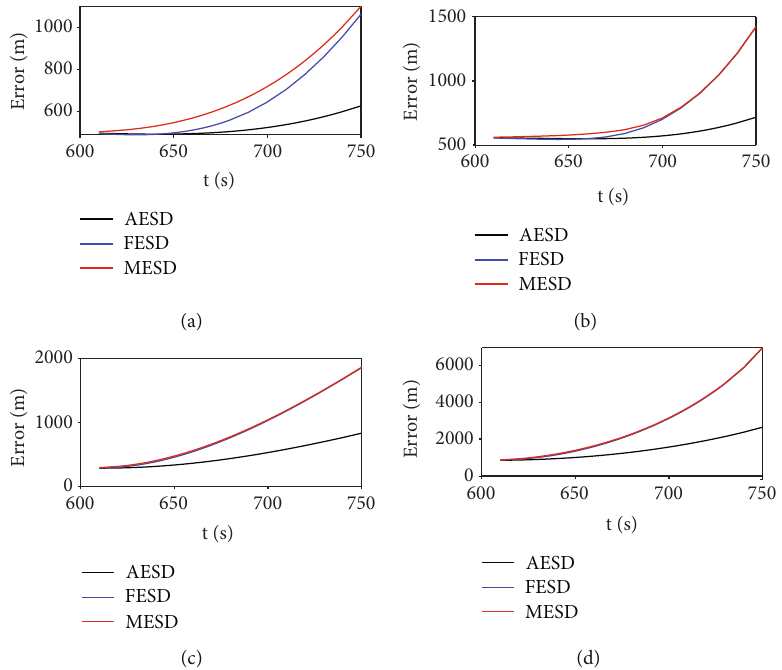
Figure 10: Variation of trajectory prediction ’ s error. (a) is the prediction error in weaving equilibrium glide. (b) is the prediction error in weaving skip glide. (c) is the prediction error in turning equilibrium glide. (d) is the prediction error in turning skip